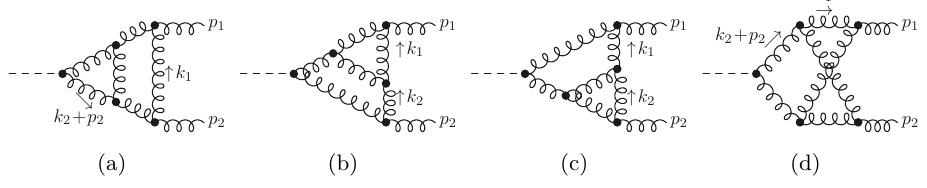
Figure 2 . Representative two-loop (parent) topologies with seven propagators present in the scattering amplitude H → gg .